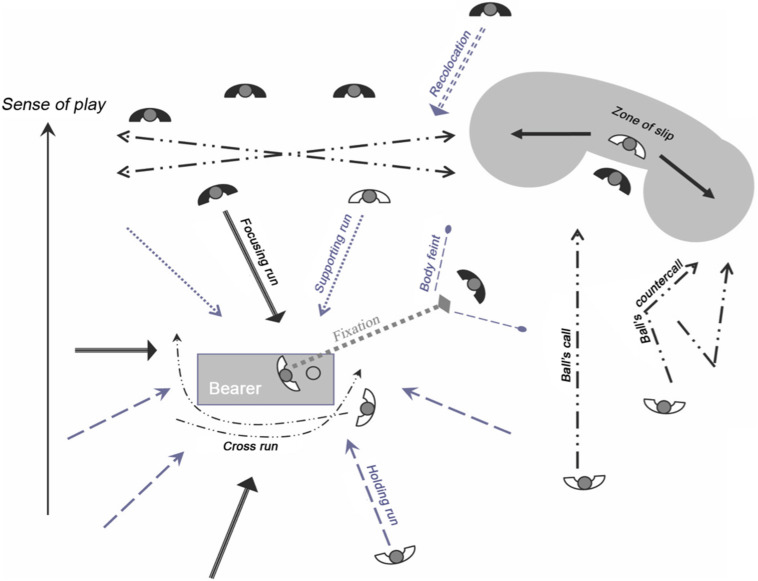
The main praxemes mobilized by footballers during the course of the game. Four praxemes do not appear on the diagram. (i) “Returning run,” which is the driving action of a player who returns to his side after his team loses the ball; (ii) “Tracking run,” which is the driving action of a player who returns to his side by following an opposing player after the loss of the ball by his team; (iii) “Shooting feint”; (iv) “Passing feint.”